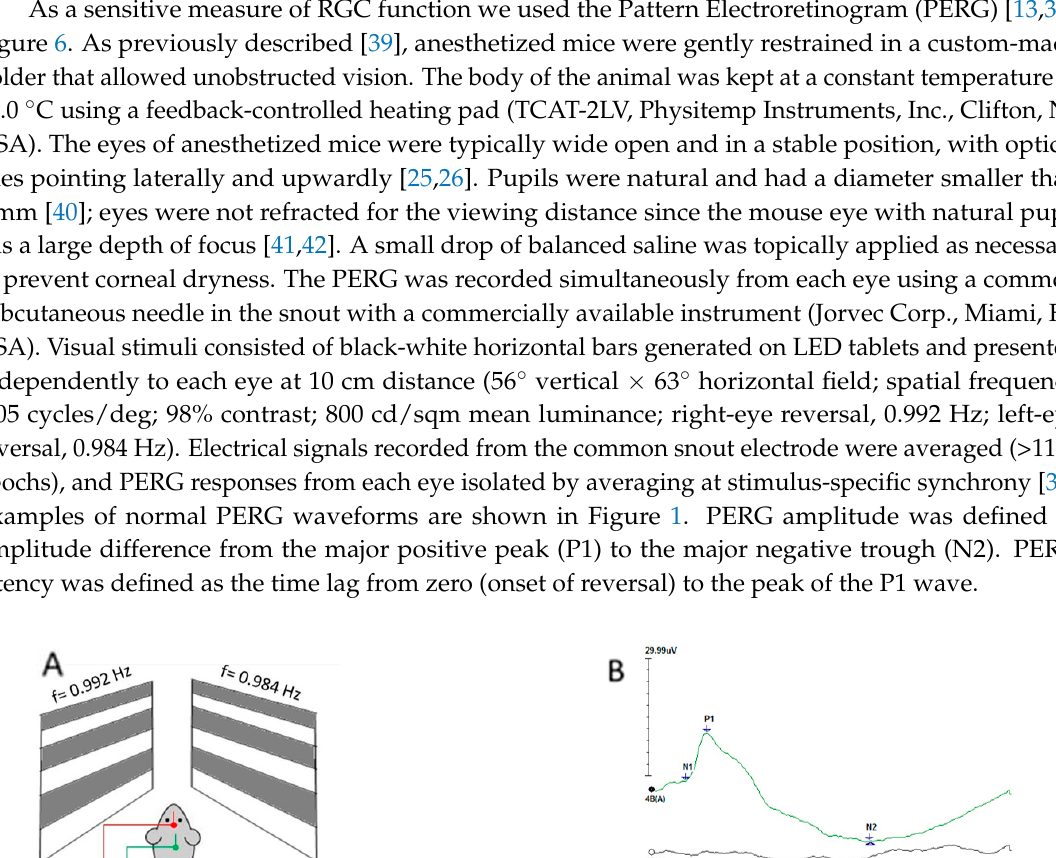
Figure 6. ( A ) Mouse PERG recording layout; ( B ) PERG waveforms simultaneously recorded from each eye using one common electrode in the snout; ( C ) Mouse with non-corneal subcutaneous needle electrodes resting on a feedback-controlled thermostatic plate; ( D ) Patterned visual stimuli generated on high luminance (800 cd/sqm) LED displays and presented at each eye independently with slightly different reversal frequency (right eye: 0.984 Hz; left eye: 0.992 Hz). Asynchronous averaging allows isolation of monocular PERGs. 4.3. Western Blots Expression of relevant retinal neurotrophic expression (BDNF, TrkB), synaptic markers (PSD95, synaptophysin) and glial markers (GFAP) was performed with Western Blot. Eyes were harvested, and retinae dissected from the pigment epithelium. Retinae from each eye were pooled separately and homogenized in RIPA buffer containing 1XHALT protease inhibitor cocktail (Pierce, Rockford, IL, USA). The protein concentrations of retinal homogenates were estimated using DC protein assay (Bio-Rad, Hercules, CA, USA). Equal concentration of the total protein samples (40 µg) were added to the Laemmli buffer, boiled at 95 °C for 5 min ad further electrophoresed on 4–20% Mini-Protean TGX precast gels (Bio-Rad). The separated proteins were transferred onto a 0.2 µm polyvinylidene difluoride membranes (PVDF, Bio-Rad). Membranes were blocked in 5% milk in 1× Tris-buffered saline + Tween (TBST) for 1 h at room temperature. The blocked membranes were incubated with primary antibody for overnight at 4 °C. Membranes were washed three times for 15 min, and then incubated with secondary antibody for 60 min at room temperature. For each sample, three gel runs were performed. To normalize for protein loading, membranes were stripped and then reprobed with constitutively expressing housekeeping gene (GAPDH). Primary were: BDNF (Novus, Littleton, CO, USA) NBP2-36705, 2 µg/mL; TrkB (Cell Signaling Technology, Danvers, MA, USA) #4603, 1:1000; PSD95 (Abcam, Cambridge, MA, USA) ab76115, 1:1000; GFAP (Cell Signaling Technology #12389, 1:1000), Synaptophysin (Cell Signaling Technology, #5461, 1:1000) and GAPDH (Cell Signaling Technology, #8884, 1:1000). Membranes were washed three times for 15 min and developed with enhanced chemiluminescence (ECL; Bio-Rad) solution. The developed bands were quanti fi ed using ImageJ software for gel densitometry (provided in the public domain by the National Institutes of Health, available online: http://rsbweb.nih.gov/ij/download.html). The relative density of protein